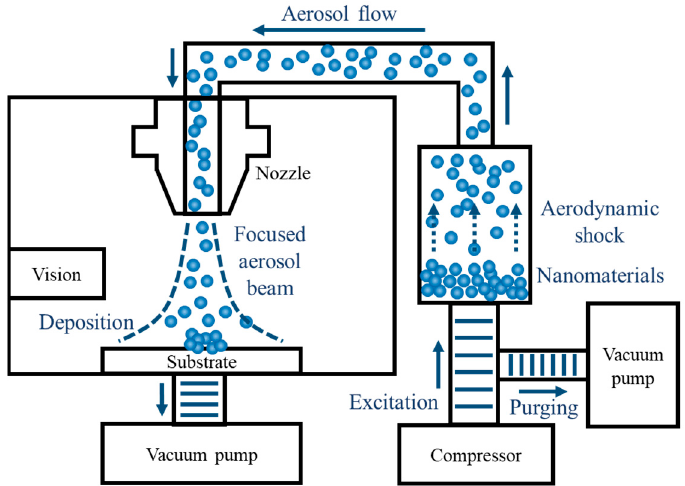
Figure 1. Schematic diagram of an aerodynamically-focused nanomaterials printing system.